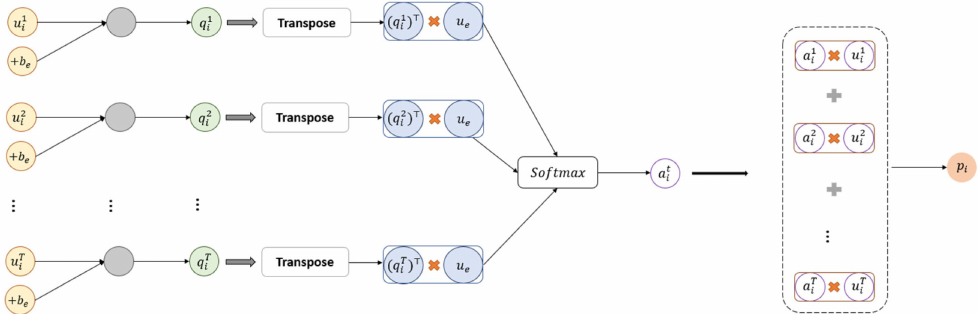
Figure 4. Attention weights for all upper-level